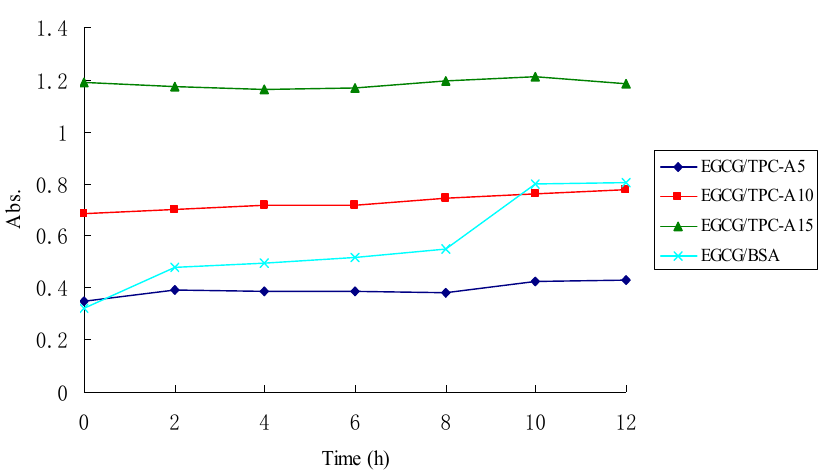
Figure 4. The turbidity evolution curve of TPC-A/EGCG aqueous mixtures at 520 nm during 12 h storage.